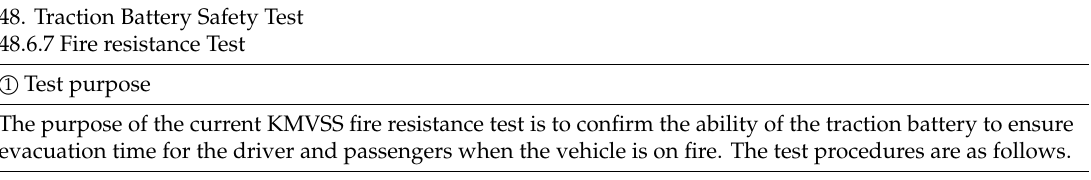
Table 1. Traction battery safety test 48.6.7 explaining fire resistance test in KMVSS Test Procedure Annex